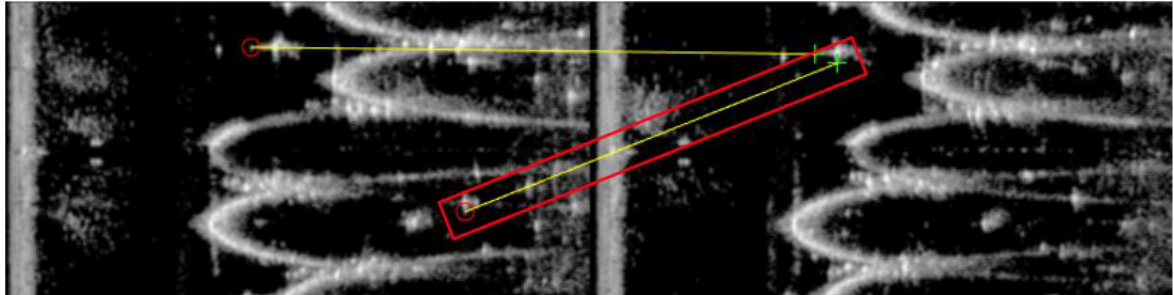
Figure 14. An example of a matching outlier, highlighted in